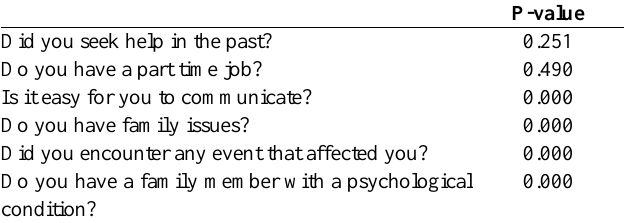
Table 4: P-value for the rest of demographics in relation to